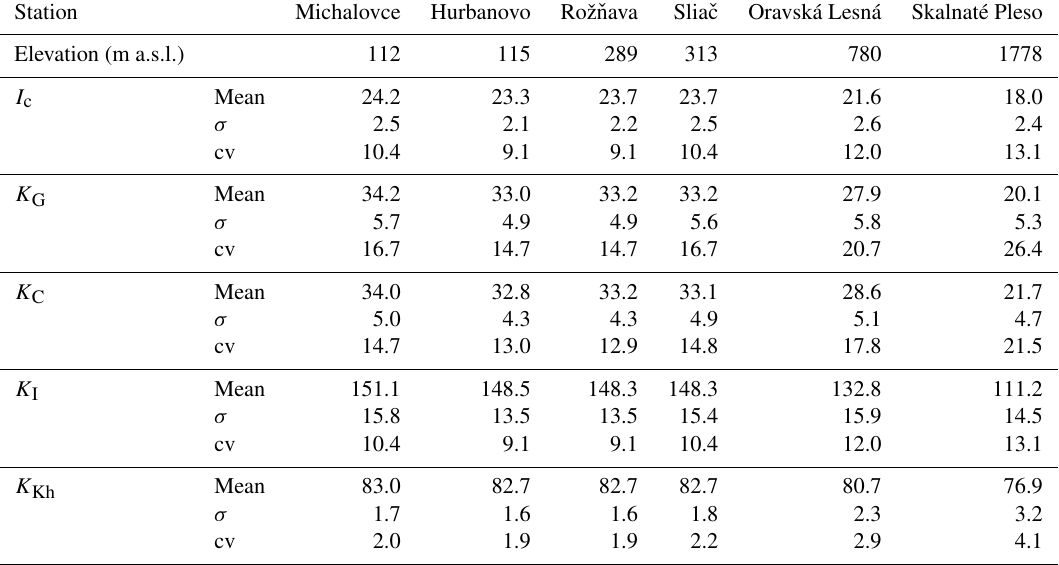
Table 3. Mean, standard deviation ( σ ) and coefficient of variation (cv) of five continentality indices: Continentality index ( I c ), Gorczynski ( K G ), Conrad ( K C ), Ivanov ( K I ) and Khromov ( K Kh ) for the period 1961 to 2013. Station Michalovce Hurbanovo Rožˇnava Sliaˇc Oravská Lesná Skalnaté Pleso Elevation (m a.s.l.)